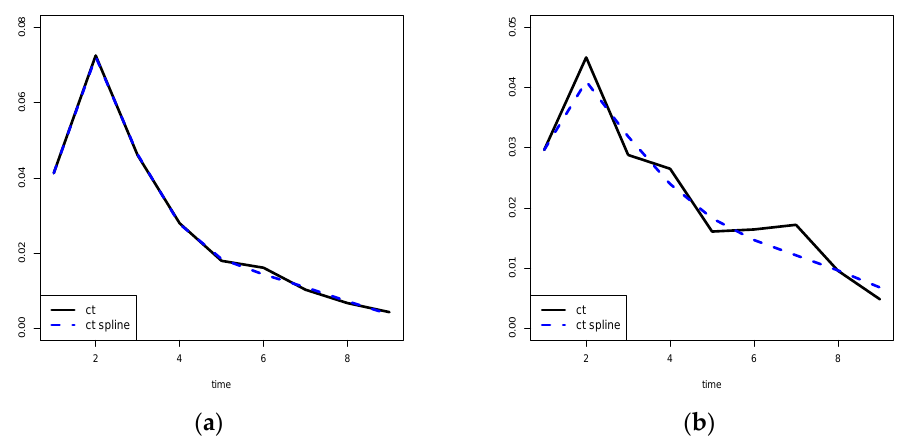
Figure 8. Conditional recovery rate at time t ( c t ) smoothed and non-smoothed for ( a ) portfolio 1; and ( b ) portfolio 2.